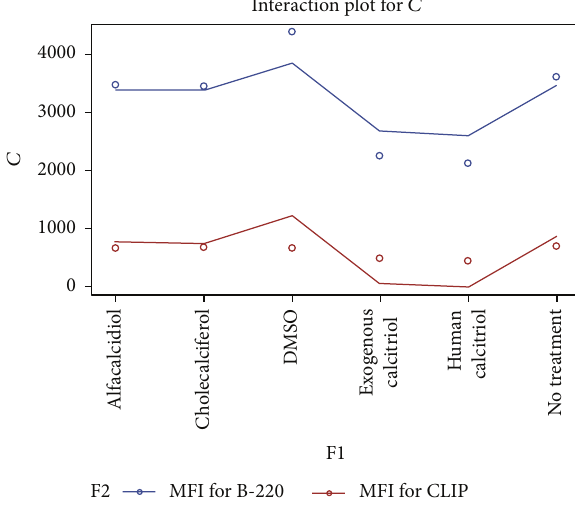
Figure 6: This linear graph demonstrates the impact of the various vitamin D compounds at 10.0 mg/dL on the density of cell surface CLIP expression and B220 subsets of B cells 15hrs after treatment using the vitamin D3 compounds versus nontreatment or DMSO. These results suggest that the active formulation of vitamin D3 once again leads to a statistically significant reduction in CLIP expression on polyclonally activated splenic B cells even at a higher concentration of 10mg/dL. Administration of the human calcitriol of vitamin D3 ( 𝑃 = 0.0181 ) resulted in the greatest overall reduction in the MFI (443.3) versus a baseline of 701.1 for no treatment and 667.7 for the control of CLIP expression on mitogen stimulated B